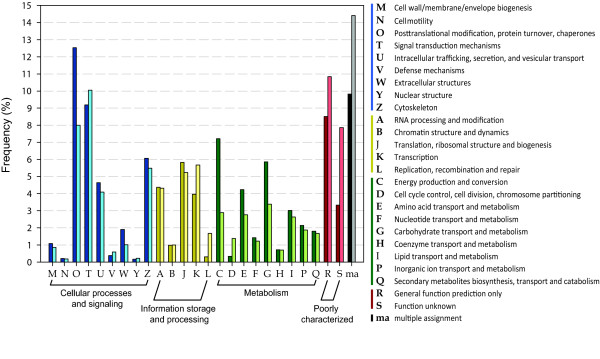
Functional assignments to the KOG categories. The graph shows the assignment of the Haliotis midae contigs and the Lottia gigantea clustered ESTs to the 25 categories of the eukaryotic orthologous groups of proteins (KOG). The main KOG categories are represented with different colours. Darker variants of each colour indicate the H. midae matches while lighter variants those of L. gigantea.